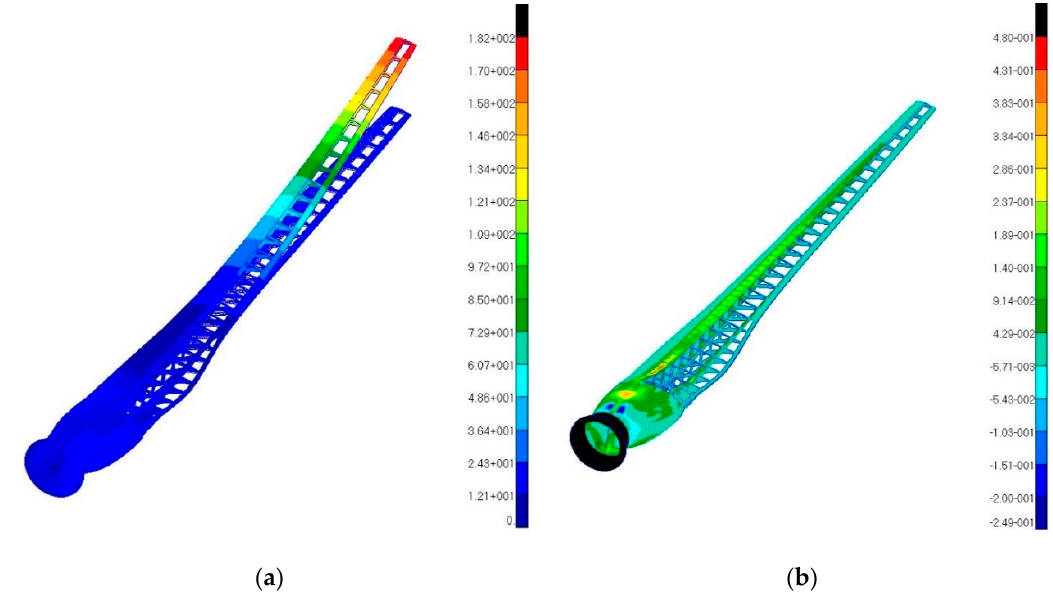
Figure 11. The structural analysis results of the 3D blade model: ( a ) deflection and ( b ) Tsai–Wu failure criteria indexes.